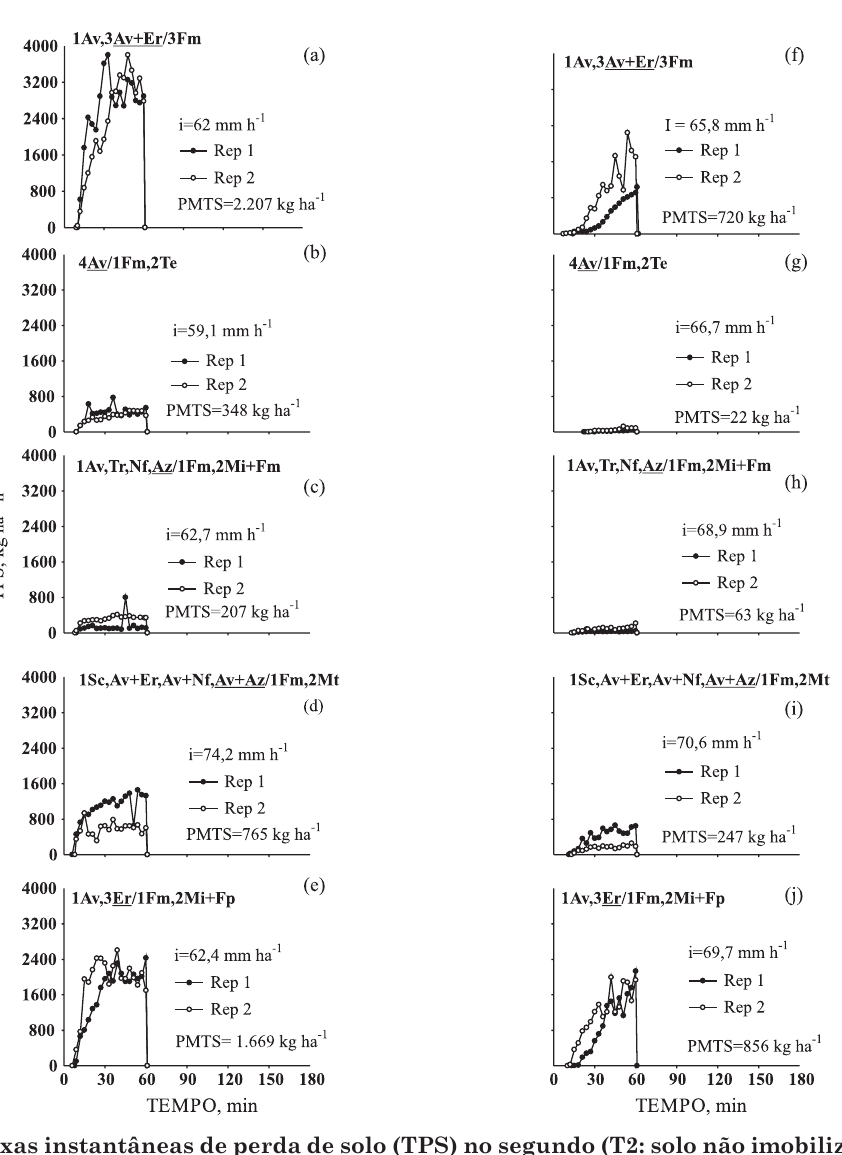
Figura 6. Taxas instantâneas de perda de solo (TPS) no segundo (T2: solo não imobilizado, raízes mortas, crosta rompida, 18 % coberto – figuras (a) a (e), à esquerda) e no terceiro (T3: solo não imobilizado, raízes mortas, crosta recente, 18 % coberto – figuras (f) a (j), à direita) teste de erosão com chuva simulada, nas sequências culturais estudadas (Av: aveia-preta, Er: ervilhaca, Fm: feijão-miúdo, Te: teosinto, Tr: trevo-calypso, Nf: nabo forrageiro, Az: azevém, Mi: milho, Sc: sem cultivo, Mt: milheto e Fp: feijão-de-porco). Valores individuais para cada repetição dos tratamentos (Rep 1 e Rep